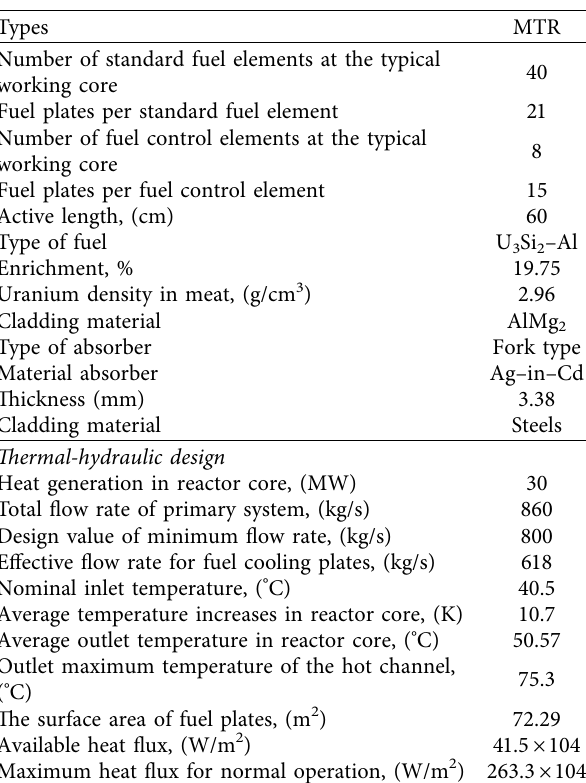
Table 1: Nuclear design parameters [22].